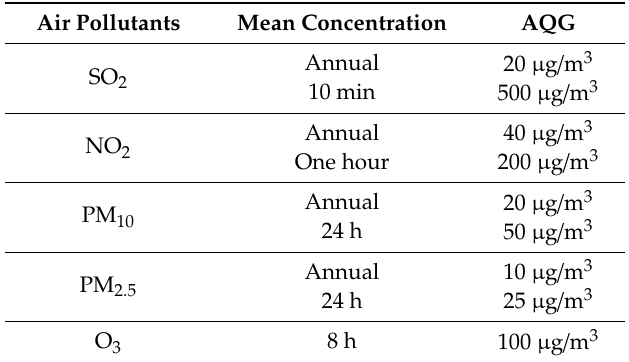
Table 2. Air Quality Guidelines (AQG) launched by WHO in